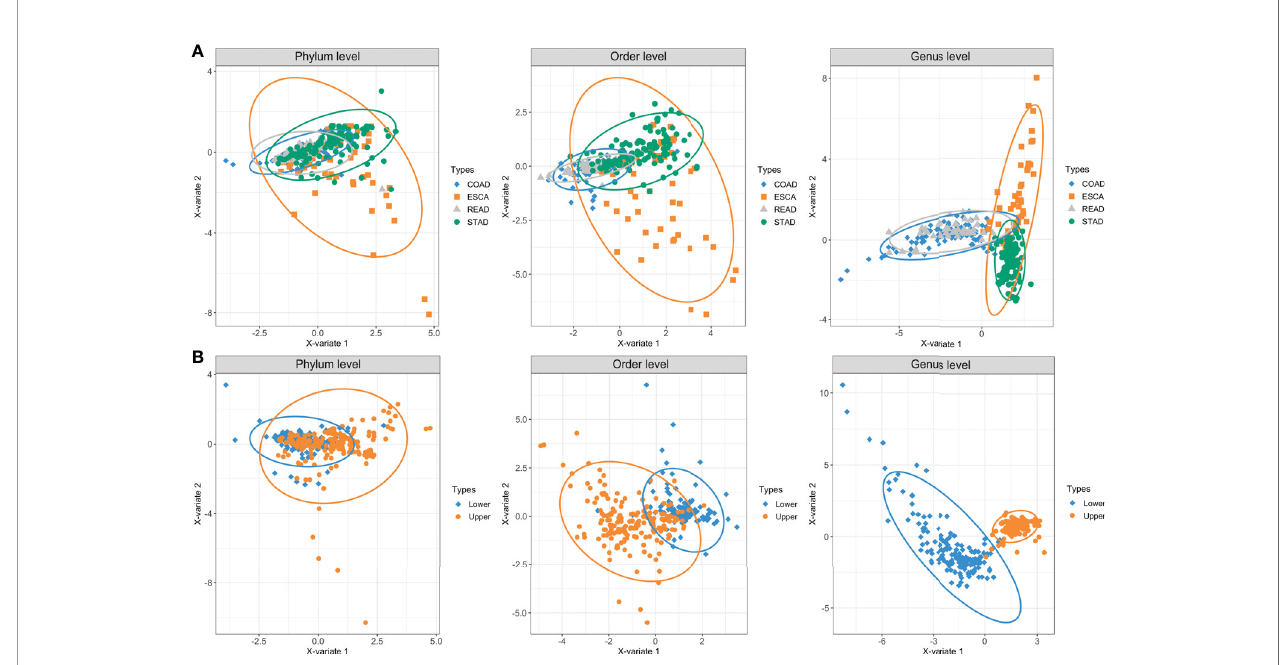
FIGURE 2 | PLS-DA plots based on the microbial pro fi le of four GI cancer types. (A) PLS-DA plots of four cancer cohorts including ESCA, STAD, COAD, and READ at the phylum, order, and genus levels. (B) ESCA and STAD were further collected as upper GI tumors, whereas COAD and READ were collected as lower GI tumors. The light ellipse in each group represents the 95% con fi dence interval (CI) of the score calculated from the corresponding group. PLS-DA, partial least squares discrimination analysis; ESCA, esophageal carcinoma; STAD, stomach adenocarcinoma; COAD, colon adenocarcinoma; READ, rectum